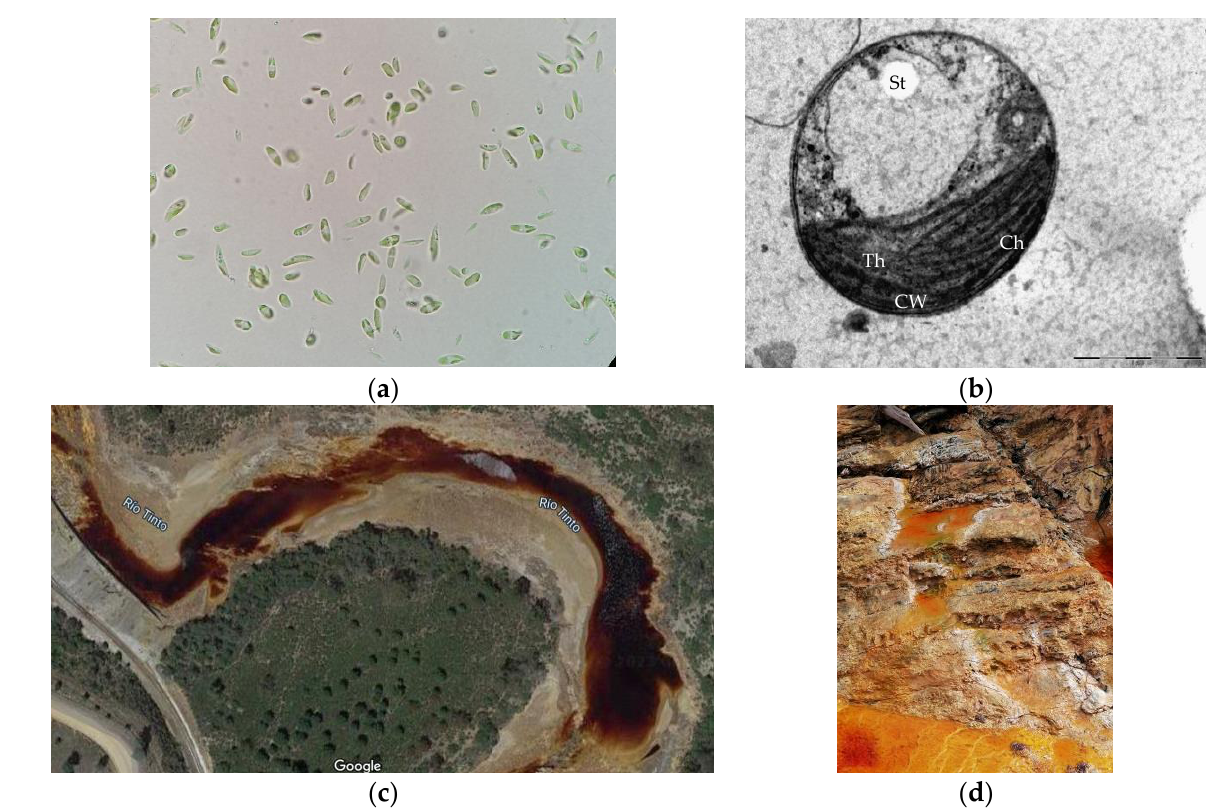
Figure 2. C. onubensis : light, 100× amplification ( a ) and transmission electron microscopy ( b ), scale bar 1 µ m ( × 30,000). Abbreviations: Ch, chloroplasts; Th, thylakoids; St, starch grains; CW, cell wall. Tinto River: satellite image of google maps ( c ) and sampling location ( d ).